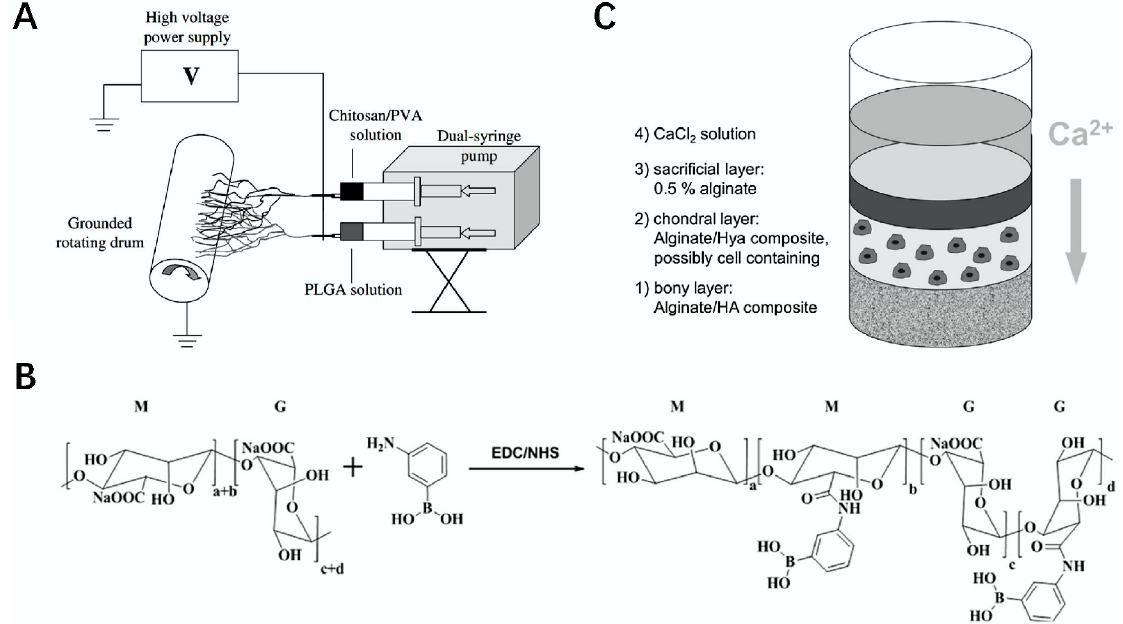
Figure 6. Preparation of materials using related polysaccharides and their applications. ( A ) schematic diagram of the electrospinning of PLGA–chitosan/PVA nanofiber composite film [88]. ( B ) schematic diagram of the preparation of the Alg–APBA composite microneedle [89]. ( C ) bipolar scaffolds prepared with sodium alginate [90].